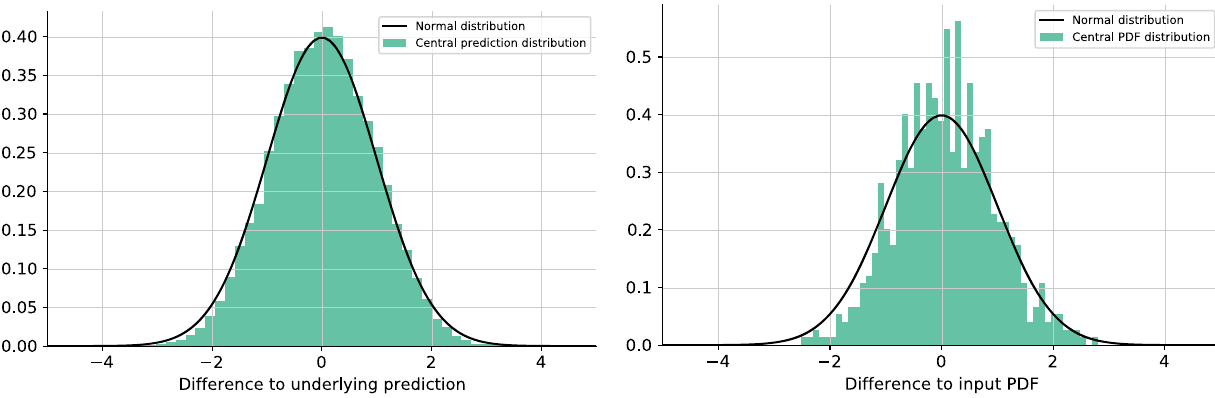
( l ) Eq. (6.20 in PDF space (right). In both i , j